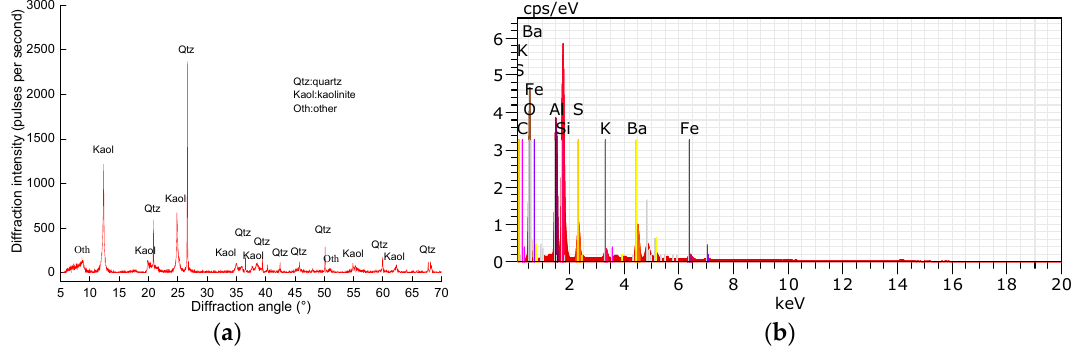
Figure 2. Composition characteristics analysis of sample. ( a ) X-ray diffraction pattern; ( b ) energy spectrum analysis.